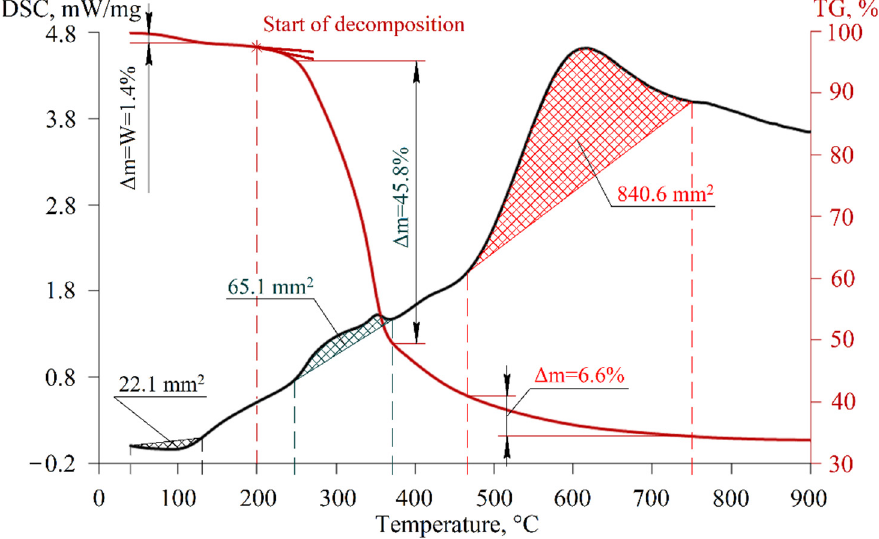
Figure 6. Numerical analysis of the TG/DSC results. Table 2. Siberian pine nutshell pyrolysis: heat expenses and exothermic effects dependent on tem- perature.